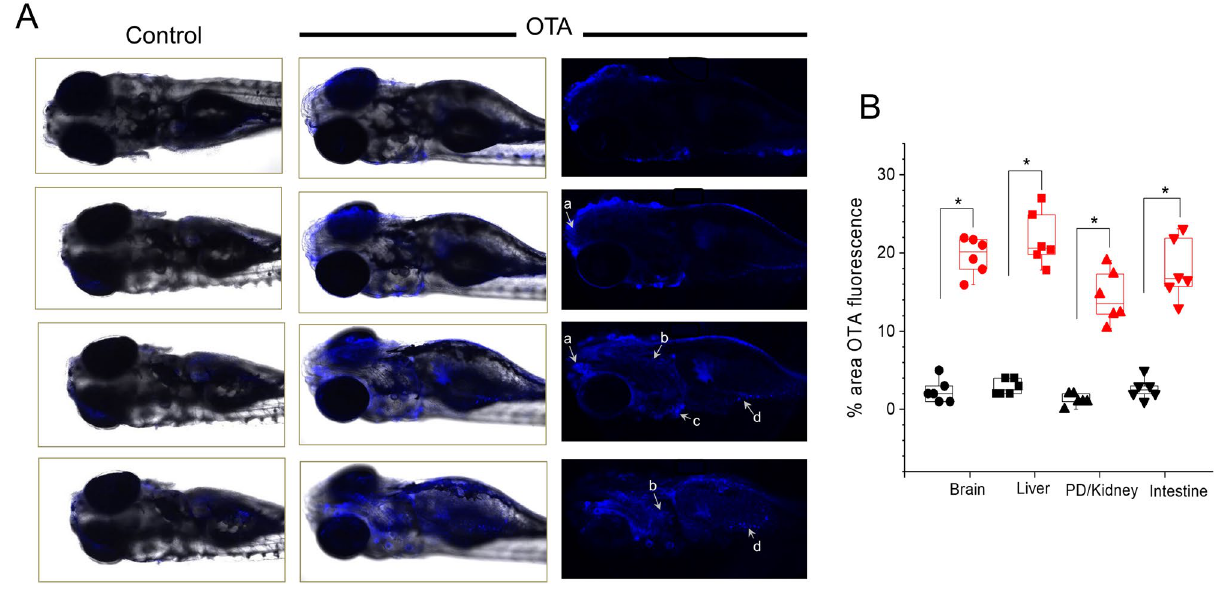
Figure 3. Distribution of ochratoxin A (OTA) visualized based on its intrinsic fluorescence. ( A ) The distribution of OTA is shown in the body of 120-hpf zebrafish embryos exposed to 4 µM OTA for 48 h, in comparison to untreated (i.e., “Control”) 120-hpf embryos. Left and middle columns show successive slices through the Control and OTA-treated embryos, respectively, with fluorescence (blue) overlayed on bright field images. Right column shows corresponding fluorescent images of ochratoxin-treated embryos without overlay. As indicated, OTA is accumulated in brain (a), pronephric duct/kidney (b), liver (c) and intestine (d). Images were acquired using inverted laser-scanning confocal microscope (Leica DMi8/TL LED, Leica Microsystems CMS GmbH) with an excitation wavelength of 380 nm, and emission wavelength of 460 nm. A Leica HC PL Apo CS2 (10x/0.15 Dry) objective, and Leica Application Suite X (LAS X) software package version 3.1.5, were used to capture images. ( B ) Quantitative analysis of OTA fluorescence in brain, liver, pronephric duct (PD)/ kidney and intestine of OTA treated zebrafish embryos (red) as compared to untreated control (black) (n = 6 per group). * P <